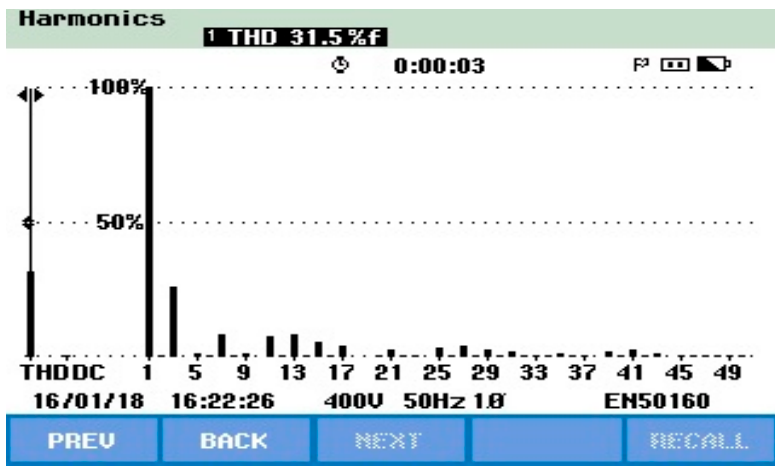
Figure 31. THD analysis of the TLBDCLCHB inverter output using the EPCAD technique.